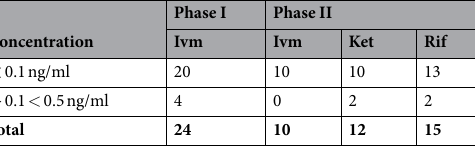
Table 2. Number of CSF samples with detectable and quantifiable ivermectin divided by study phase and treatment group. Footnote: Ivm: ivermectin only group, Ket: ketoconazole + ivermectin group, Rif: rifampicin + ivermectin group.